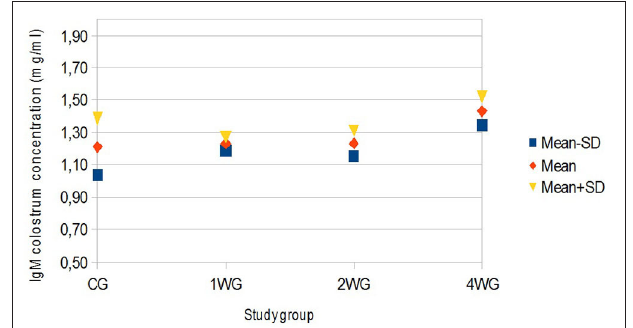
FIGURE 2 | Variability of colostrum IgM concentration depending on study group. Results are presented as mean ± SD. CG, control group; 1WG, one-week group; 2WG, two-week group; 4WG, four-week group. Each study group enrolled 5 bitches.